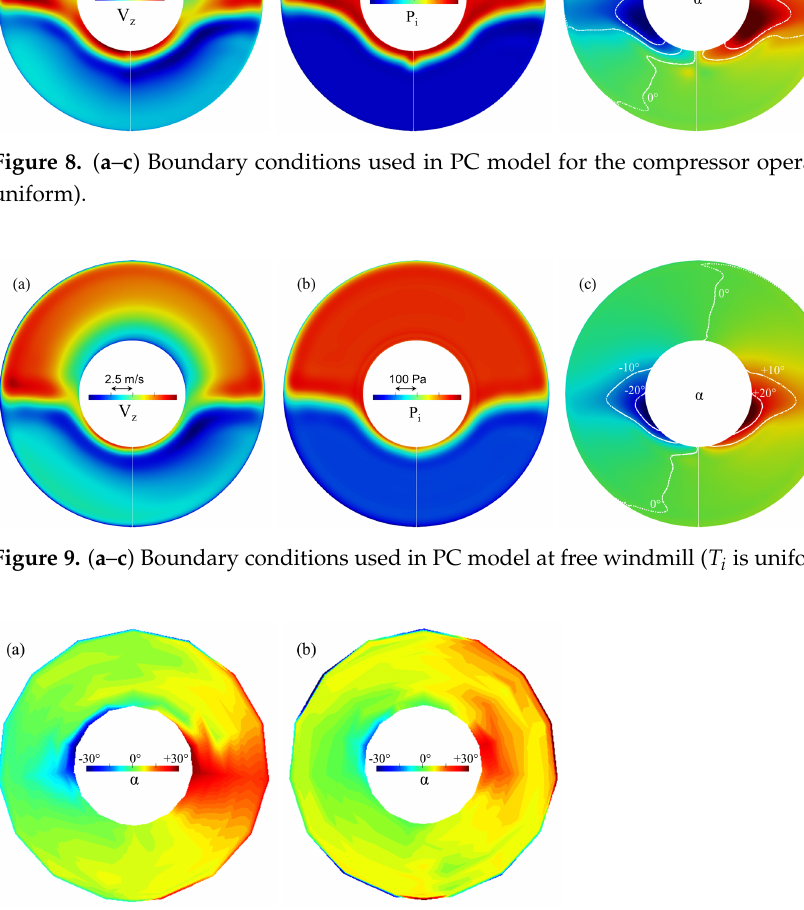
Figure 10. Swirl angle measured at rotor LE: compressor ( a ) and free windmill ( b